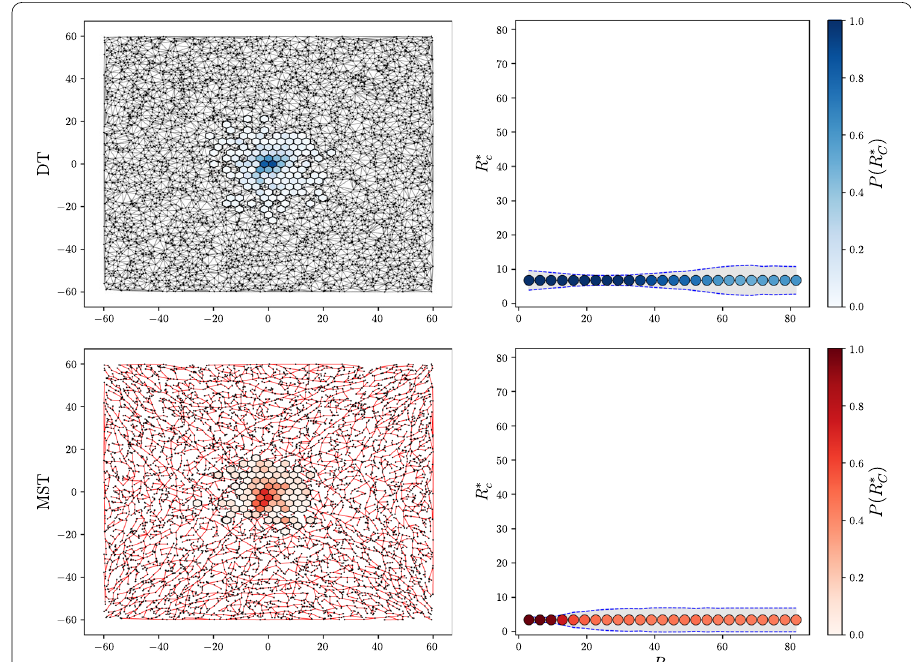
Fig. 2 Spatial behavior of congestion for a DT (top) and a MST (bottom) networks, built on a uniform distribution of N = 6000 nodes in a square with side length L = 60 . Left column contains the graphic representations of the networks. Hexagonal bins provide information about the occurrence of congestion nodes in space, and their colors show the related frequency in proportion to the intensity. In the right column we present the dependence of the congestion radius R c on the patch radial size R p , i.e., the radius of the circle centered in the middle of the network, that is used to define the considered subgraph within this radius. The congestion radius range is divided in bins, and each point is located at the statistical mode R ∗ c obtained with the distribution of R c after 100 realizations. The color of the circular markers shows the probability of that value over the experimental R c distribution. Shadow areas represent the variance of the different realizations of R c values with respect to the bin average value. Importantly, congestion mostly occurs in the center and no transitions arise, suggesting that these are a consequence of the intertwining of different graph